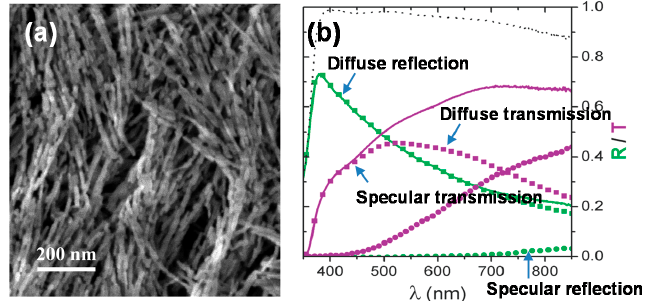
Figure 4. Fibrous network structure photoanodes comprising TiO 2 NTs. ( a ) Scanning electron microscope (SEM) image; and ( b ) transmittance and reflectance spectra of the photoanodes. Reprinted with permission from [25]. Copyright 2010 American Chemical Society.